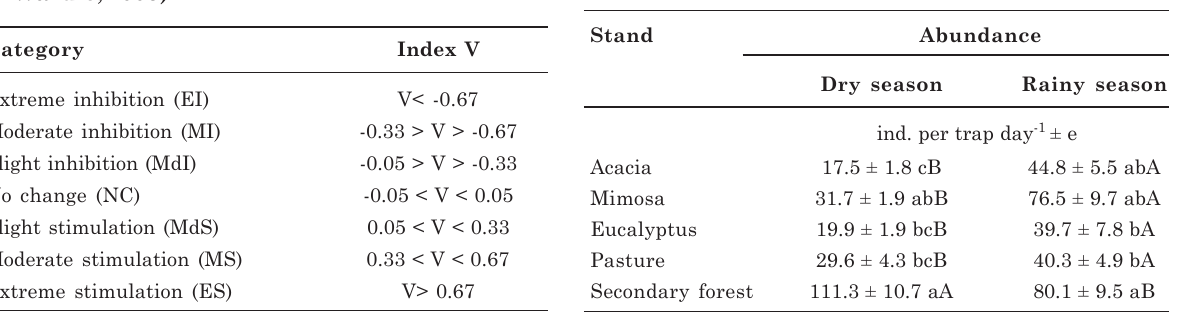
Table 2. Soil fauna abundance ± standard error